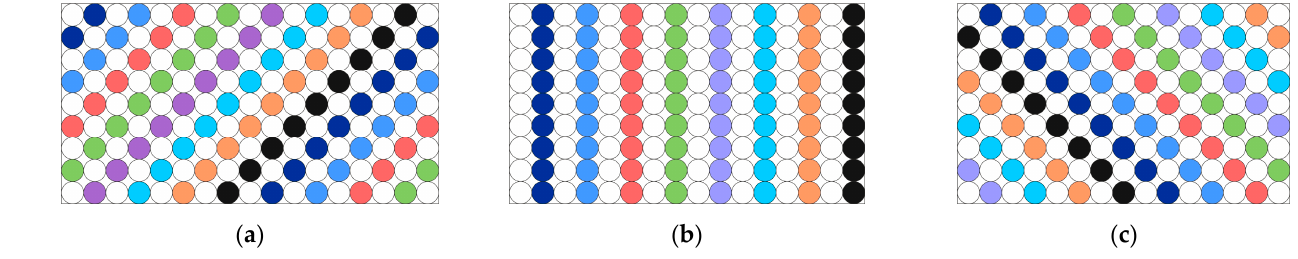
Figure 1. Image reconstructed for the correct value of the line length ( b ), the line length value too large ( a ), the line length value too small ( c ).